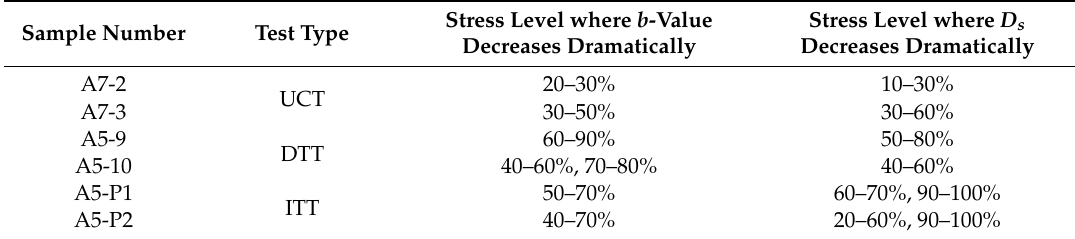
Table 3. Precursor information before failure under the di ff erent loading modes.